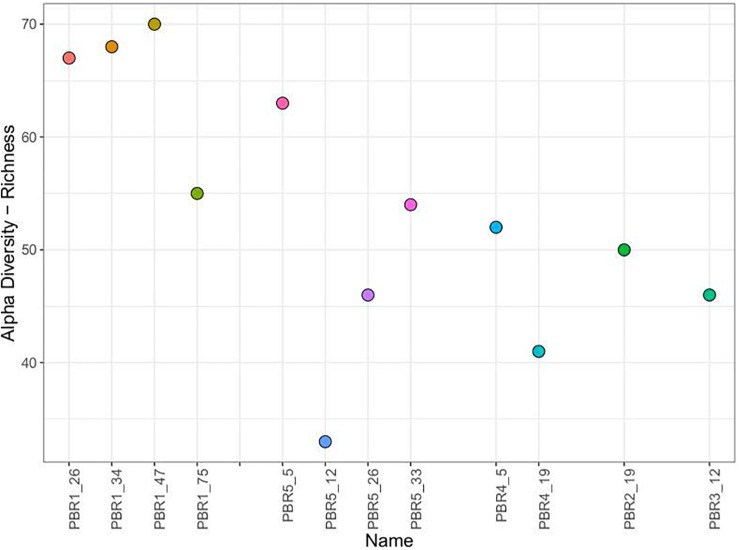
Alpha diversity (richness) of the microbial communities that selected out in PBRs.